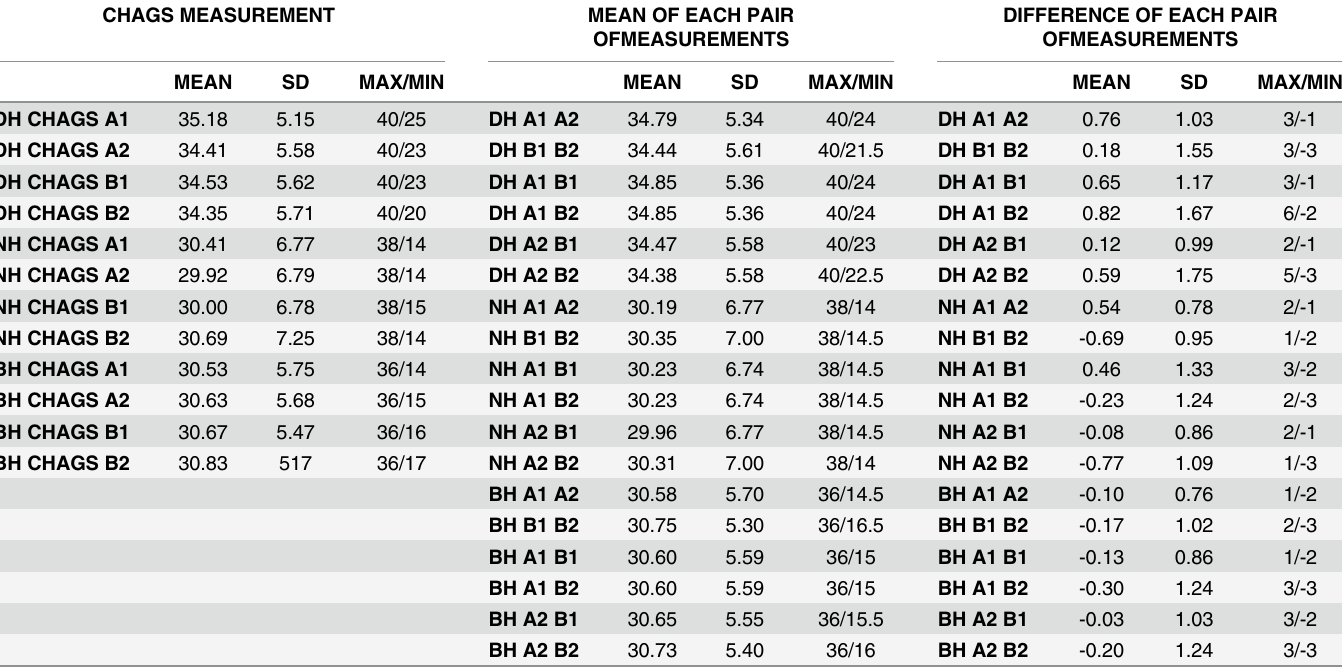
Table 1. Descriptive analysis of the results obtained in each measurement carried out on CHAGS scale.